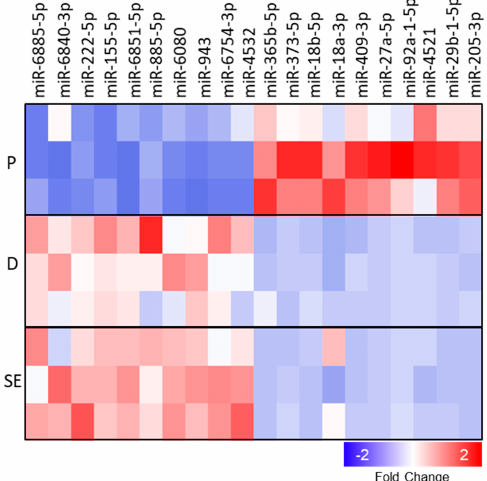
Figure 3. Top 10 up- and downregulated miRNAs during epidermal KC differentiation. The heatmap displays the top 10 up- and downregulated (upregulated red; downregulated blue) miRNAs differentially regulated between the three conditions. P, proliferating; D, differentiated; SE, skin equivalent. n =3.